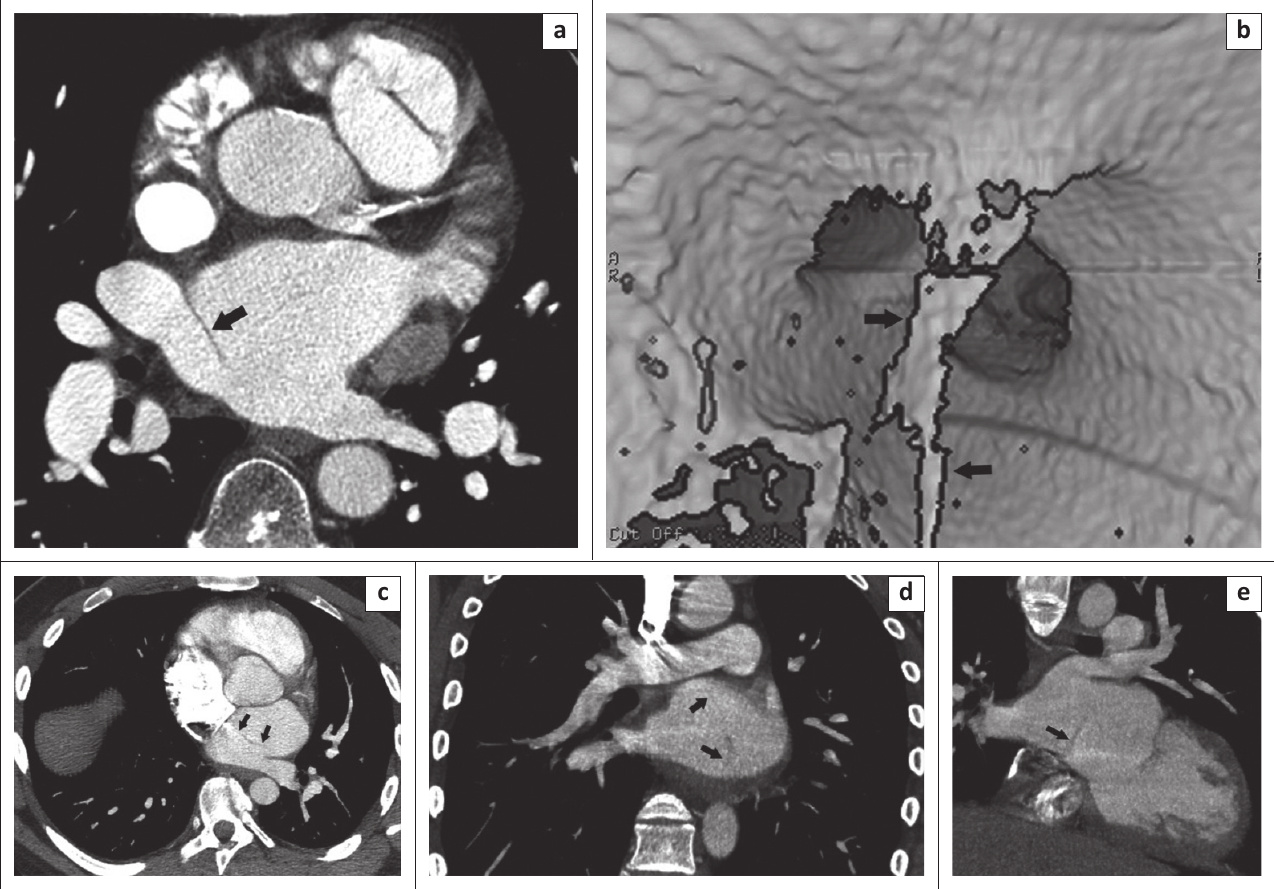
FIGURE 16: A fibromuscular membrane (arrow) separating the left atrium into two parts: the upper of the chambers communicates with the pulmonary veins and the lower with the mitral valve containing the left atrial appendage: (a) Axial image; (b) Endocardial view shows the fibromuscular membrane separating the left atrium into two parts. The lower row of images shows non-obstructive Cor triatriatum in another patient, a 28-year-old man with atrial fibrillation, fibromuscular membrane (arrow); (c) Axial image; (d) Oblique axial image; (e) Coronal image.